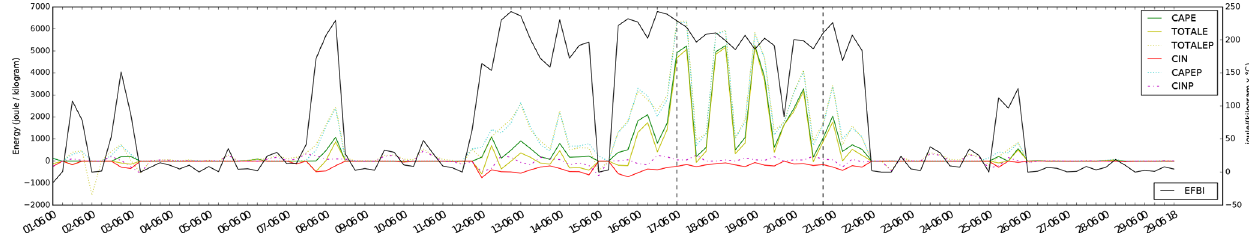
Figure 7. The EFBI and its components for the wildfire in Pedrógão Grande on June 2017 for the fire centroid ( − 8.2252, 39.952). Horizontal axis is the timeline using hourly steps in the format dd-mm hh.